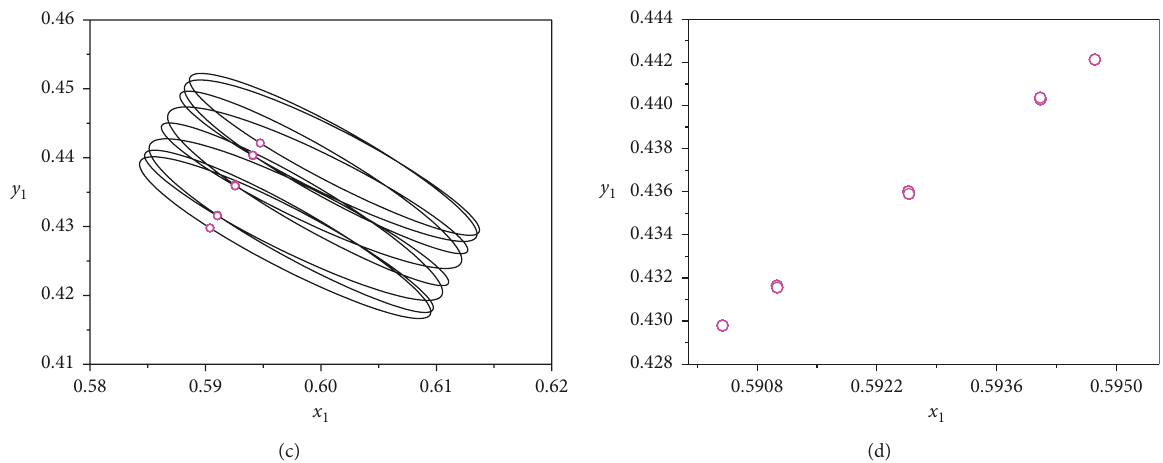
Figure 20: ω � 2.20 and ϕ � 0.055: (a) displacement response; (b) frequency spectrum; (c) rotor orbit; (d) Poincar´e maps.